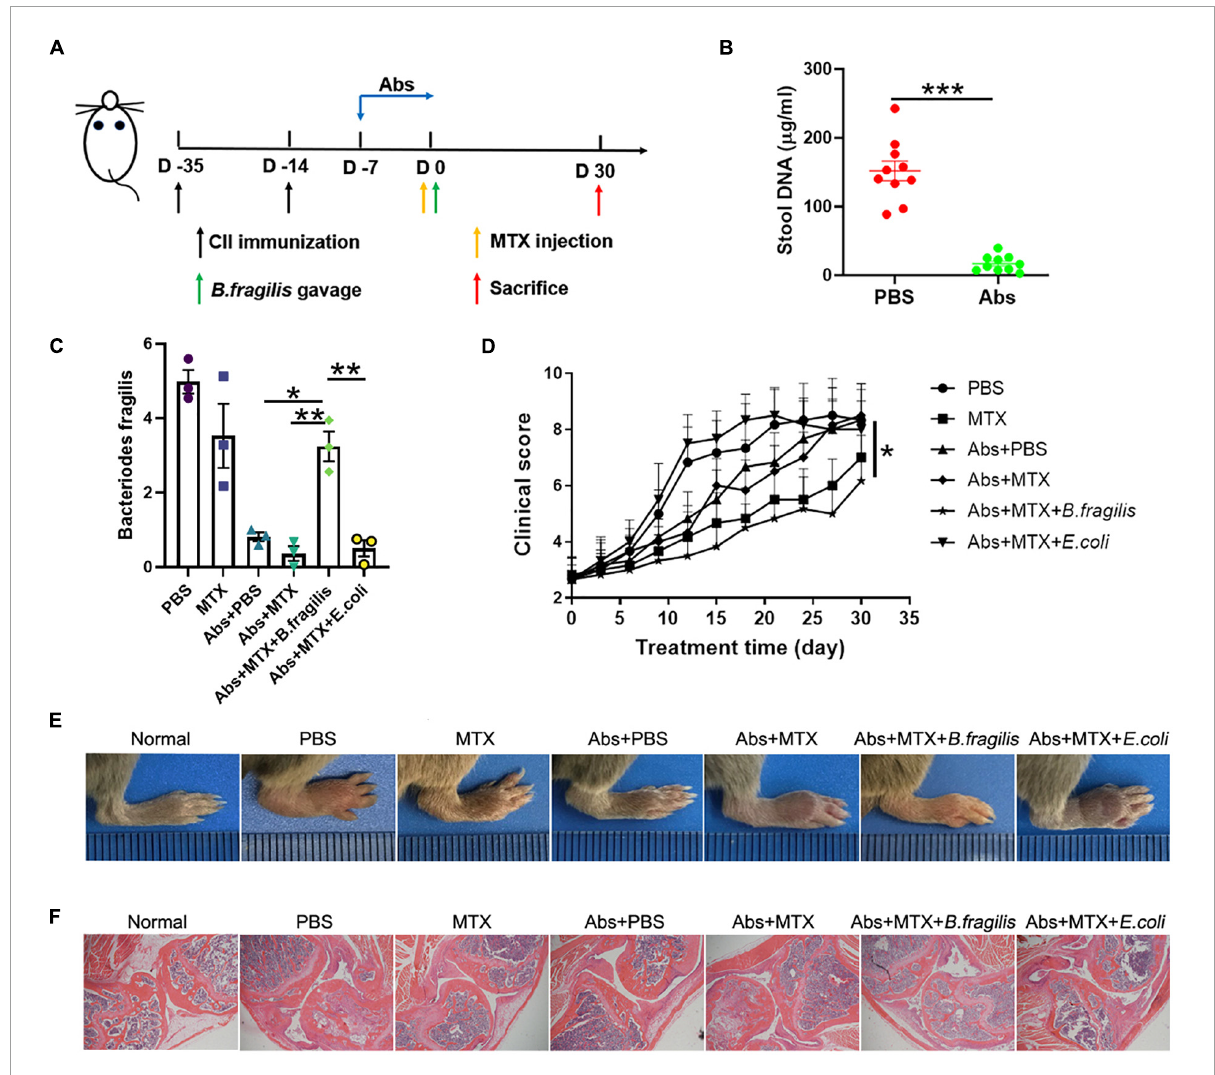
FIGURE2 The response to MTX was affected by Bacteroides fragilis in gut microbiota deficient CIA mice. (A) Schematic of treatments. Mice were treated with antibiotics at the onset of arthritis. Mice received B. fragilis gavage and MTX injection on day 0. (B) The total stool DNA after Abs treatment ( n = 10). (C) The content of B. fragilis after gavage ( n = 3). (D) Clinical scores of CIA mice ( n = 6). (E) The photos of hindlimb. (F) HE staining of joint tissues (magnification is 40 × ). Data are presented as the mean ± SEM. * p < 0.05, ** p < 0.01, *** p < 0.001. Abs,